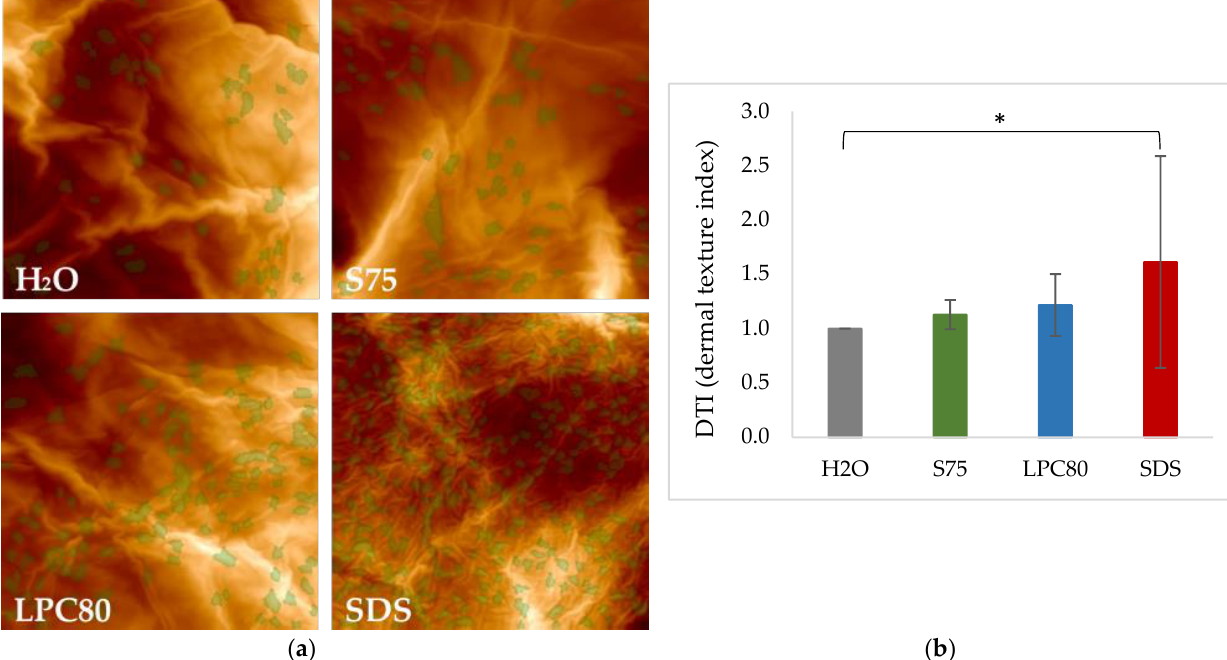
Figure 7. ( a ). Representative images of corneocyte surface morphology as assessed by AFM after exposure to S75, LPC80, SDS and water as control (H 2 O). Images were taken on corneocytes removed by adhesive tapes. Circular Nano Objects (CNOs) are depicted in green. ( b ) Dermal Texture Index (DTI) is defined as the average count of CNOs in a field of observation (20 μm) 2 . Values are means of n = 8 ± SD. Statistically significant differences are marked with asterisks (* p < 0.05) and were tested with a one-way ANOVA + post-hoc Tukey test with p < 0.05 as minimum level of significance.